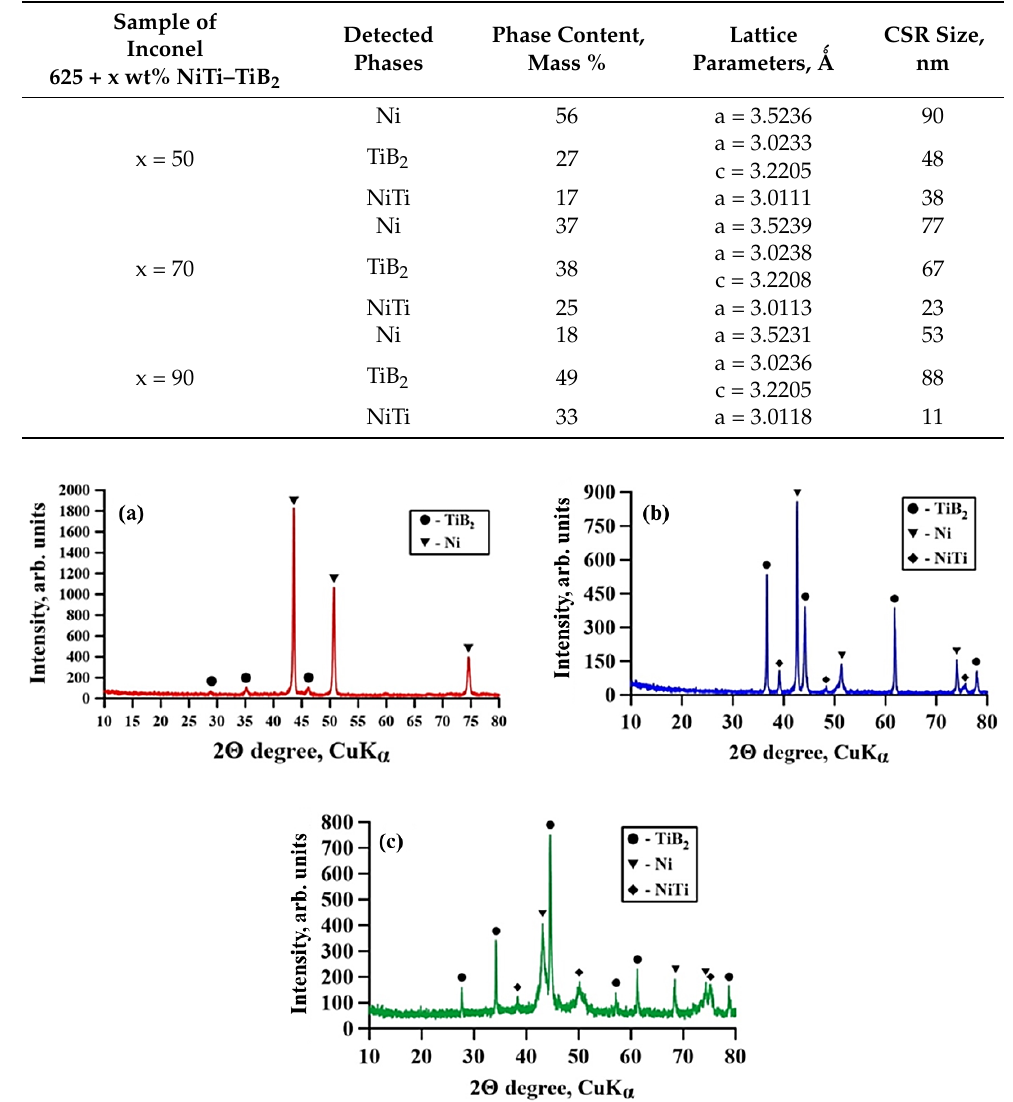
Figure 3. XRD images of composites obtained by direct laser deposition from a powder mixture of Inconel 625 + x wt% NiTi–TiB 2 : x = 5 ( a ), x = 50 ( b ), x = 90 ( c Table 2. X-ray diffraction analysis results for composites obtained by direct laser deposition from a Inconel 625 – NiTi – TiB 2 powder mixture.